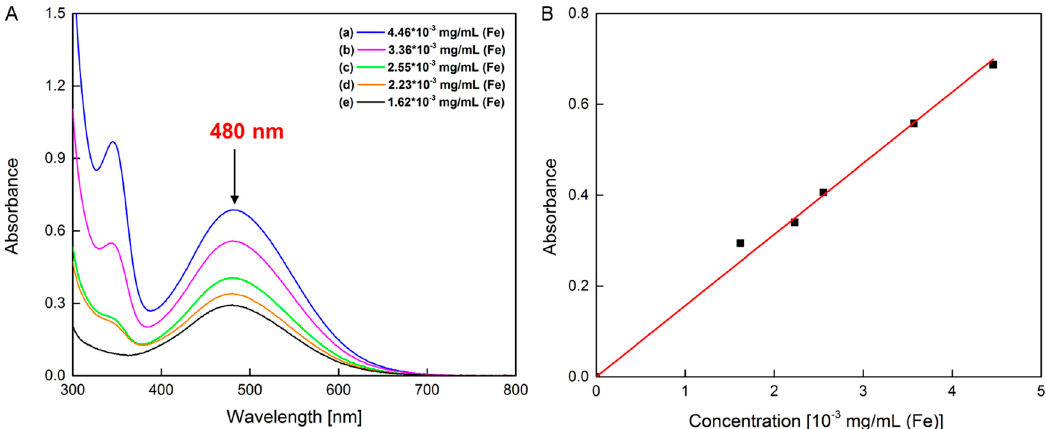
Figure 3. ( A ) UV-Vis spectra of MNPs at different concentrations, showing peak absorbance around 480 nm. ( B ) Absorbance versus concentration calibration curve for MNPs, with correlation coefficient (r 2 ) of 0.99.